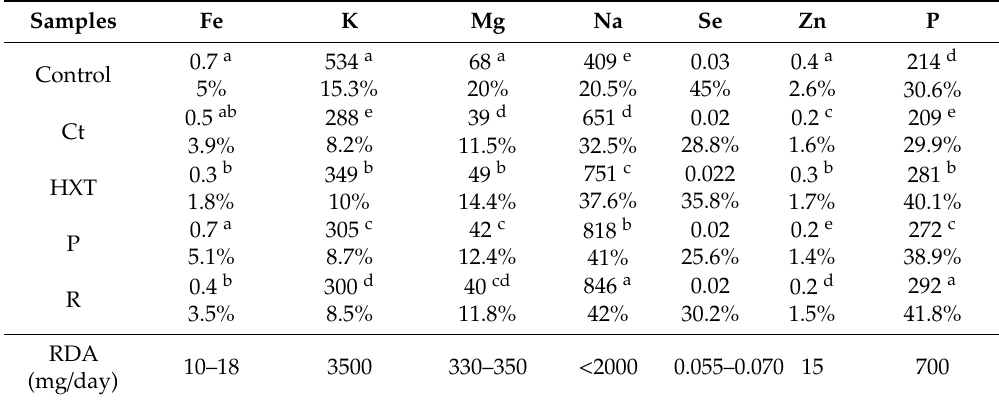
Table 2. Mineral content (m ± s.e.) (mg / 100 g) of fish patties and RDA percentage that supposes consumption of 100 g per